Question: In one sentence, what is this figure communicating?
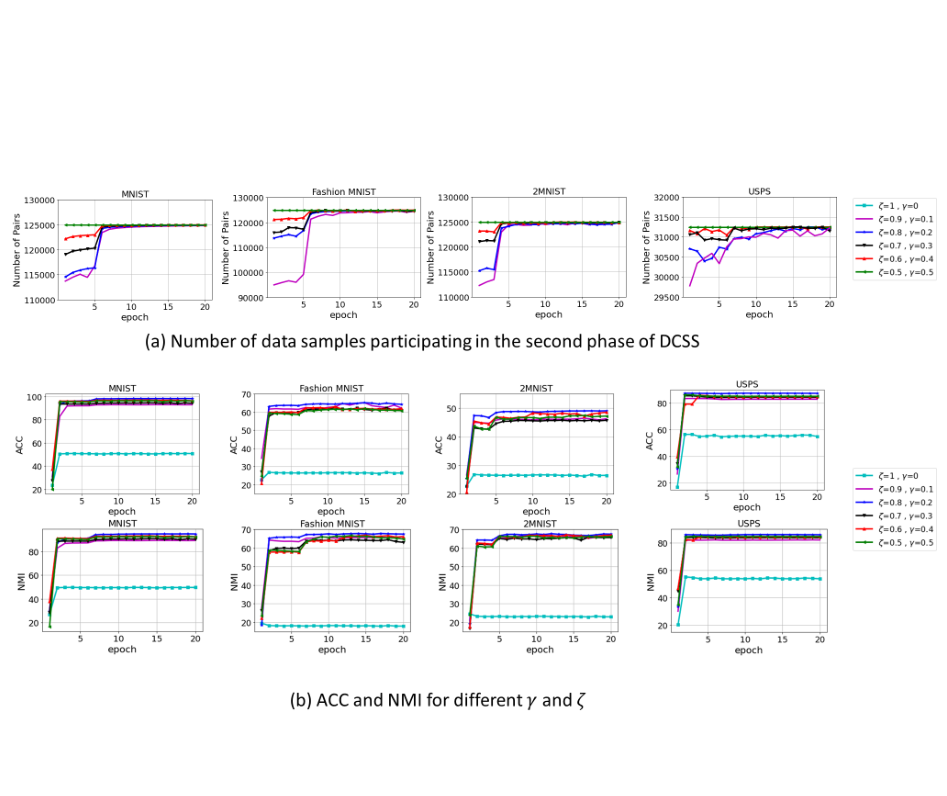
Answer: Changing hyperparameters ζ and γ for different datasets. (a) Number of data pairs par- ticipating in the second phase of DCSS. (b) Clustering performance in terms of ACC and NMI for different datasets for different values of ζ and γ; the clustering performance of DCSS is less sensitive to the choice of ζ and γ in the range of [0.5,0.9] and [0.1,0.5], respectively.